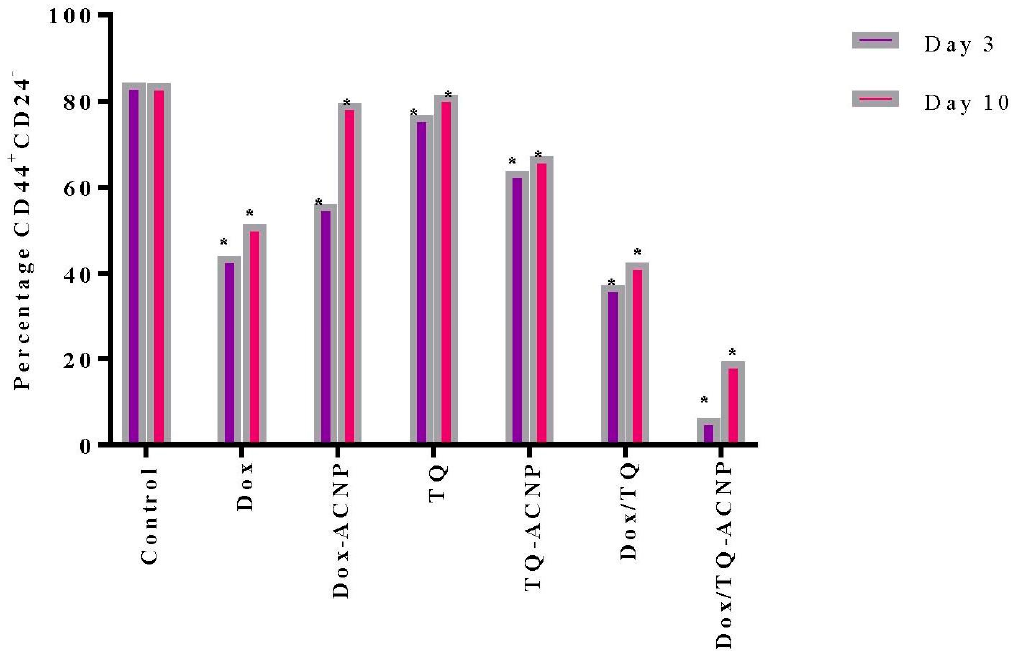
Figure 12. Graphical representation of CD44+CD24- cells after treatment at days 3 and 10.* p < 0.05 compared to control.